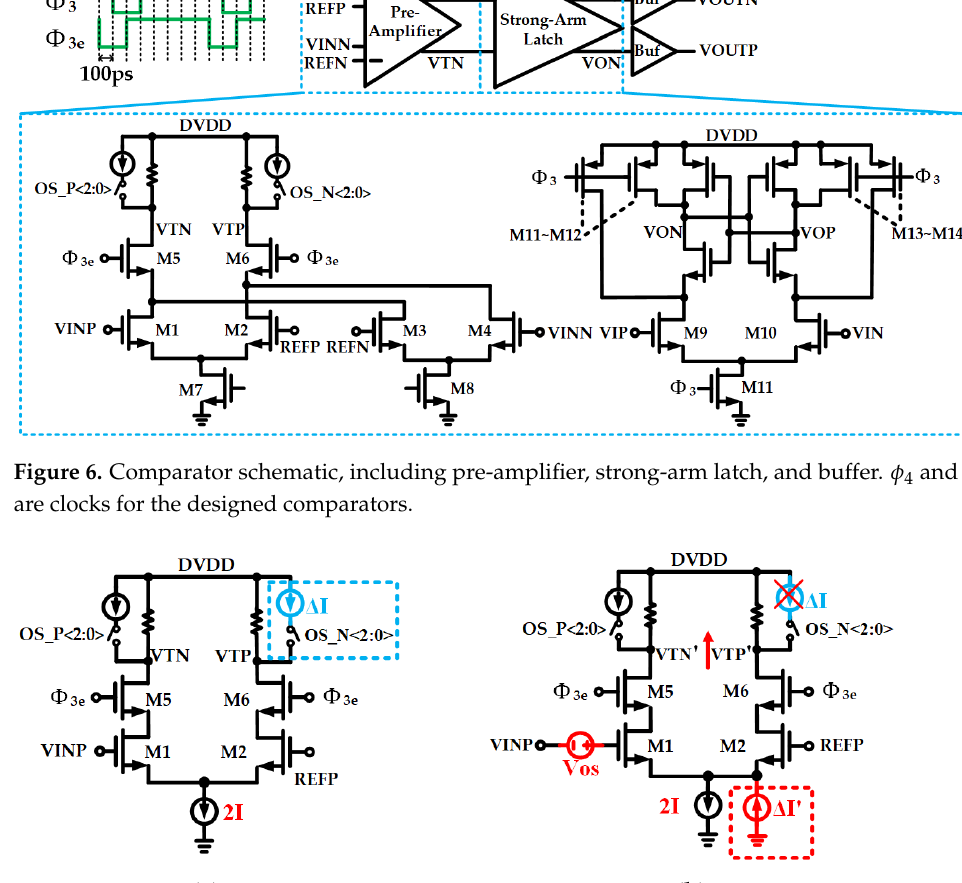
Figure 7. ( a ) Pre-amplifier with calibration. ( b ) Equivalent circuit ( a ). V OS and raised output common mode caused by ΔI.